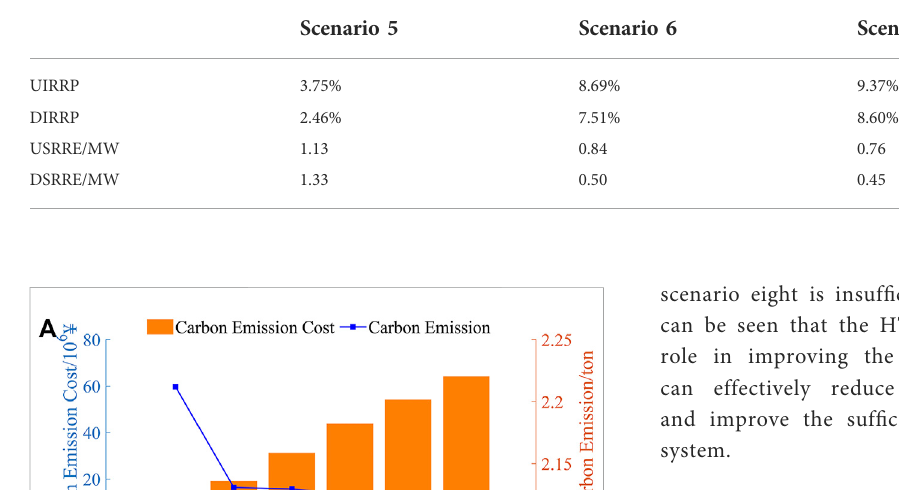
TABLE 3 The system fl exibility results under different power source constructures.